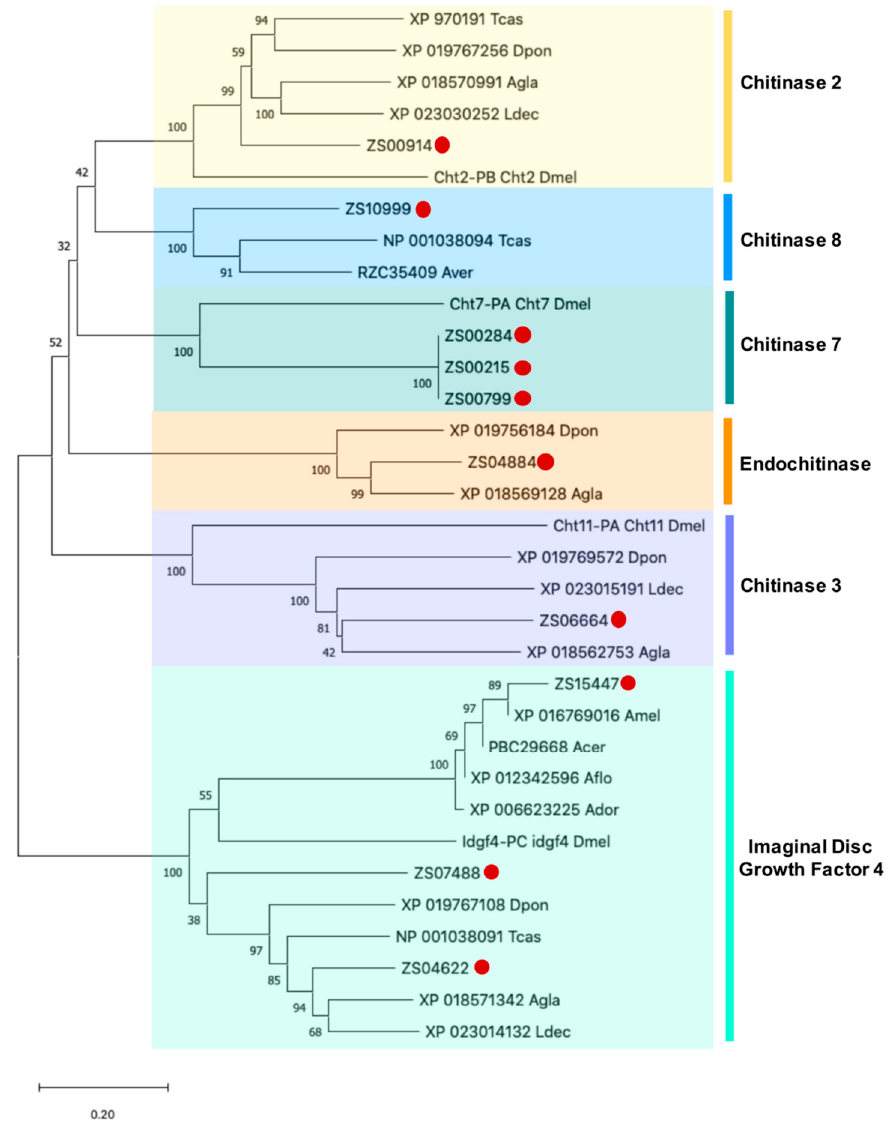
Figure 5. Phylogenetic analysis of putative IDGF4-chitinase proteins of Z. subfasciatus and other species. The phylogenetic tree was generated by MEGA X using the neighbor-joining method with 1000 bootstrap replicates. The accession number or symbol gene is shown. Amino acid sequences from other species used for comparison: Agla ( Anoplophora glabripennis ), Acer ( Apis cerana cerana ), Ador ( Apis dorsata ), Aflo ( Apis florea ), Amel ( Apis mellifera ), Aver ( Asbolus verrucosus ), Dpon ( Dendroctonus ponderosae ), Ldec ( Leptinotarsa decemlineata ), Tcas ( Tribolium castaneum ), Dmel ( Drosophila melanogaster ). The proteins were clustered into chitinase 2, chitinase 3, chitinase 7, chitinase 8, endochitinase and Imaginal Disc Growth Factor 4 groups. Colored boxes represent proteins belonging to the same group. Putative targets for PF2 lectin are identified by a red dot. The scale bar represents the branch lengths.